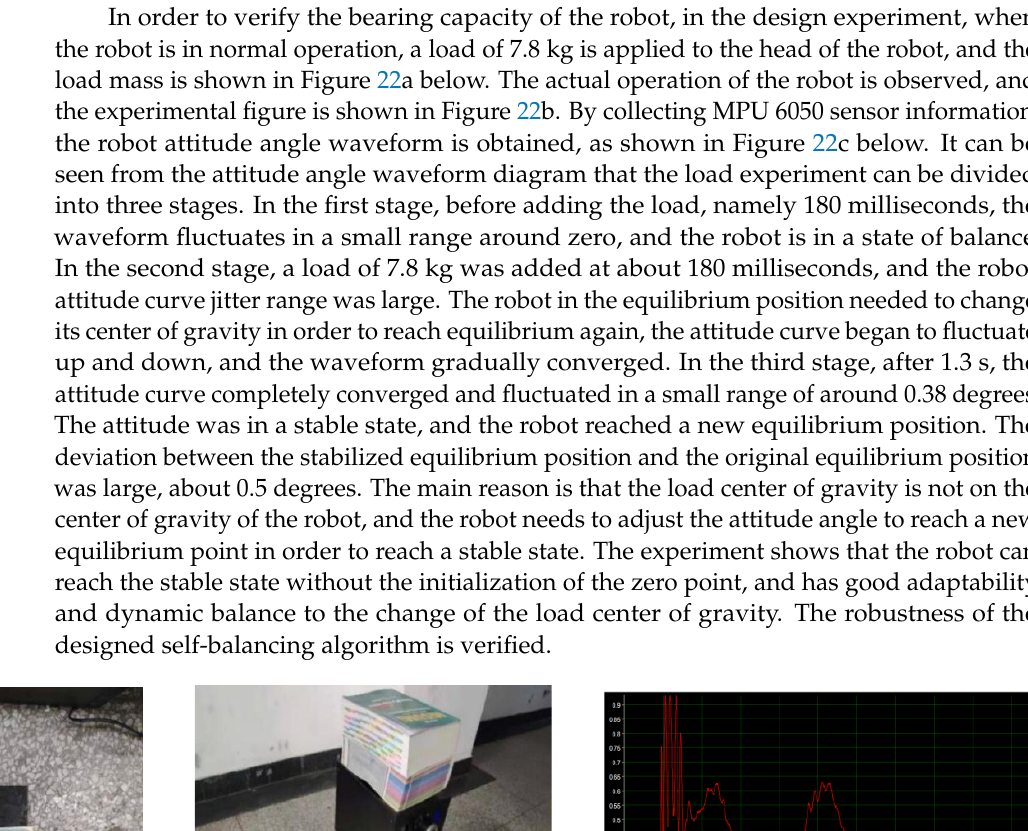
Figure 21. ( a ) Self-balancing experiment of inspection robot. ( b ) Self-balancing posture curve.